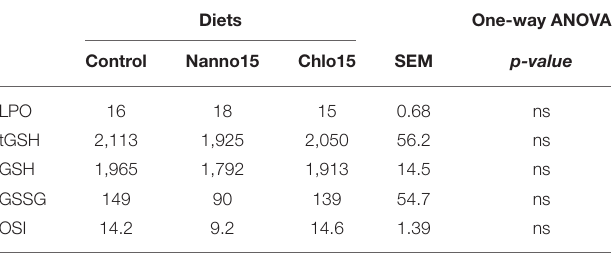
TABLE 4 | Lipid peroxidation (LPO) (nmol malondialdehyde/g tissue), total glutathione (tGSH), reduced glutathione (GSH), oxidized glutathione (GSSG) (nmol/ g tissue), and oxidative stress index (OSI) in the liver of sea bass fed experimental